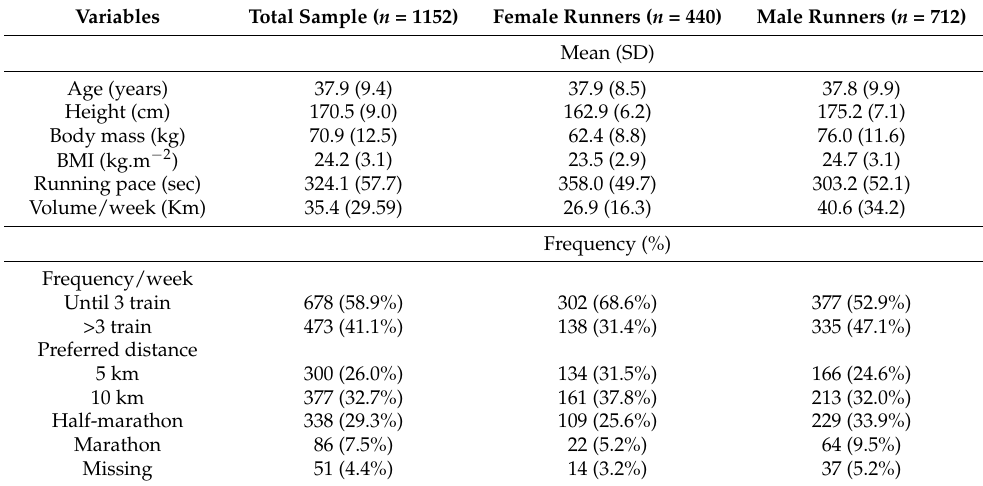
Table 1. Brazilian runners’ descriptive characteristics, by total sample and stratified by